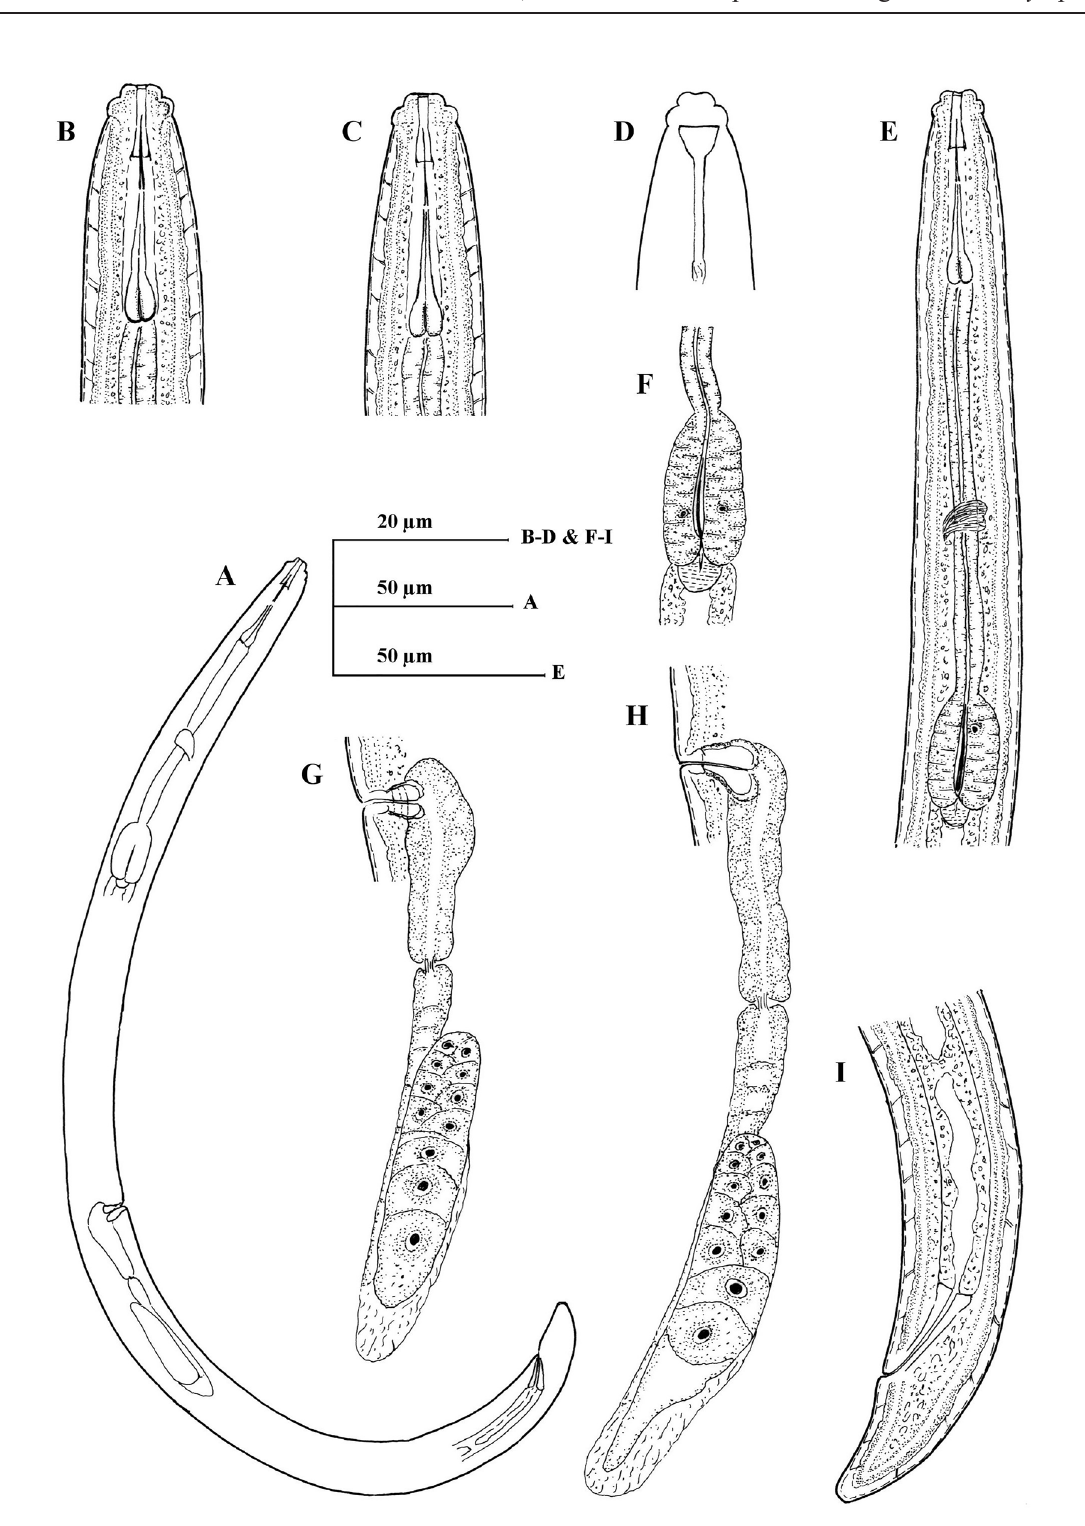
Fig. 10. Basirotyleptus constrictus sp. nov., ♀ (AMU/ZD/NC/ Basirotyleptus constrictus /2–5). A . Paratype 3. B , H . Paratype 1. C–E, I . Paratype 5. F . Paratype 4. G . Paratype 2. A . Entire specimen. B–C . Anterior region. D . Anterior region showing amphid. E . Pharyngeal region. F . Pharyngeal bulb. G–H . Genital system. I . Posterior